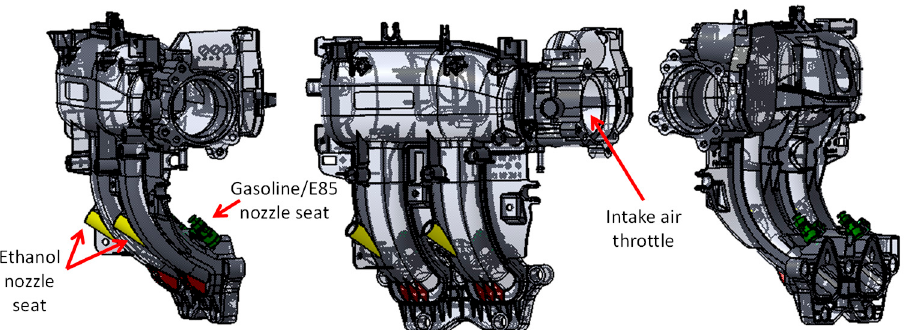
Figure 1. Schematic of intake manifold and dual fuel injection system.